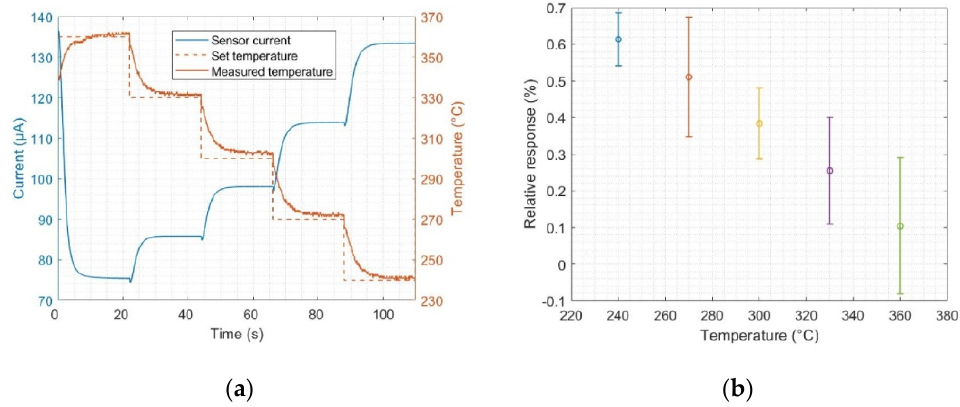
Figure 1. ( a ) Current evolution of a SiC-based field-effect transistor sensor during a temperature cycle between 360 and 240 °C, including the evolution of set and measured temperatures; ( b ) mean values and standard deviations of the relative response, calculated from the virtual sensors at the different studied temperatures for 1 ppm formic acid, as an example. By virtual sensor, we mean the mean value of the sensor signal at each temperature plateau gathered along consecutive cycles to produce an equivalent sensor signal.